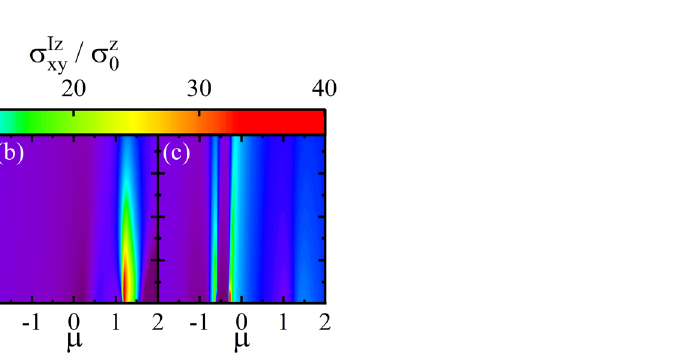
Figure 8. The spin conductivity σ Iz xy in the fBA and SCBA methods as a function of the µ for different values of M with ( a ) V = 0 , ( b ) V = 0.2 , ( c ) V = 0.4 , and ( d ) V = 0.6 . Here, the disorder parameter γ b = 0.2 .